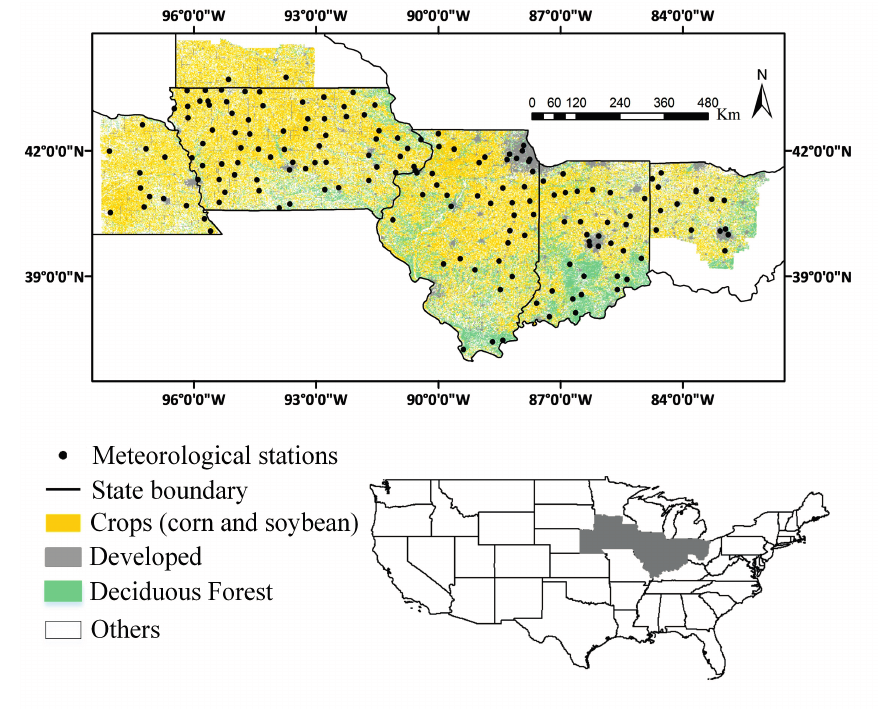
Figure 1. Map of the U.S. Corn Belt study area with the main land-cover types (from Cropland data layer data (CDL) of 2012) and spatial distribution of the meteorological stations used in this study